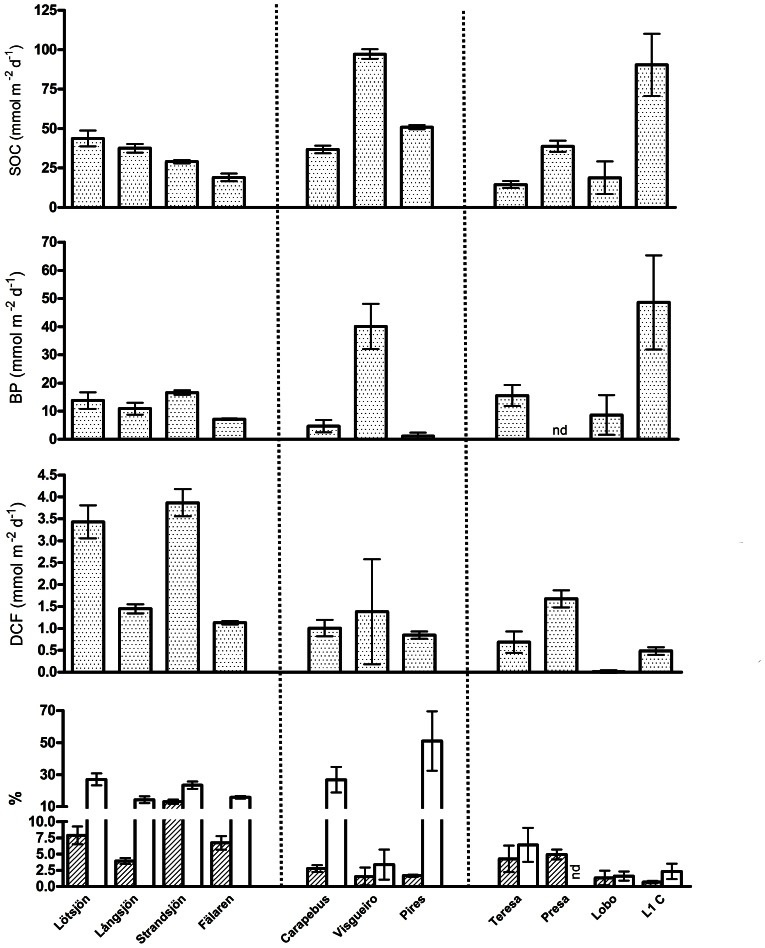
Comparison between measured sediment rates.Rates of sediment O2 consumption (SOC), bacterial production (BP), dark carbon fixation (DCF) and carbon fixation expressed as a percentage of sediment O2 consumption (hatched bars, DCF:SOC) and of bacterial production (white bars, DCF:BP) in the surface sediment for all studied lakes. Symbols represent average and plus-minus one standard error.